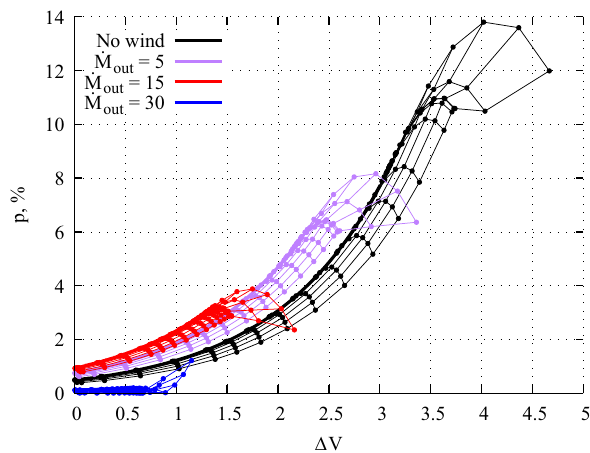
Figure 5: Dependence of the linear polarization degree on the fading level in the disk perturbation eclipse model for the same disk models as in Figure 3. The eclipses are shown with isoheights and isoextensions like in Figure 4.